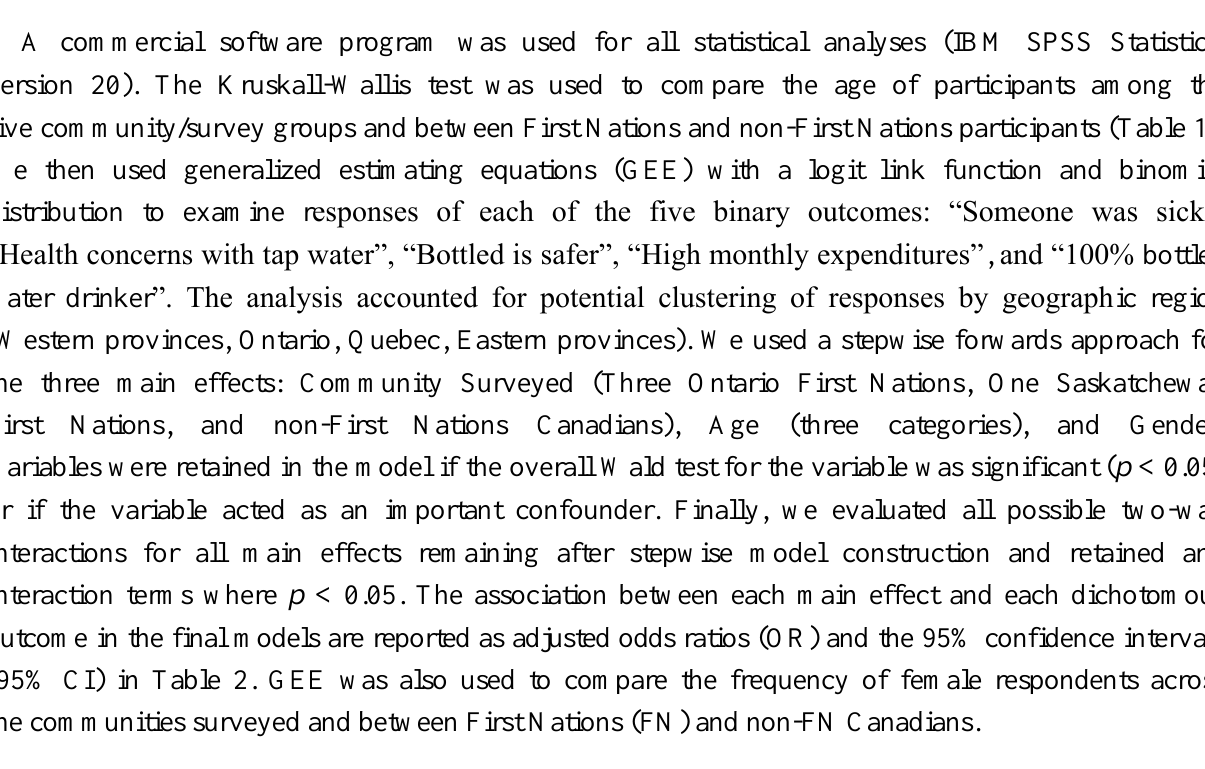
Table 1. Summary of respondent age, gender, and responses to questions (% of respective samples (n) * ) for each of the 5 participating communities from Ontario First Nations, Saskatchewan First Nations, and an internet-based cross Canada